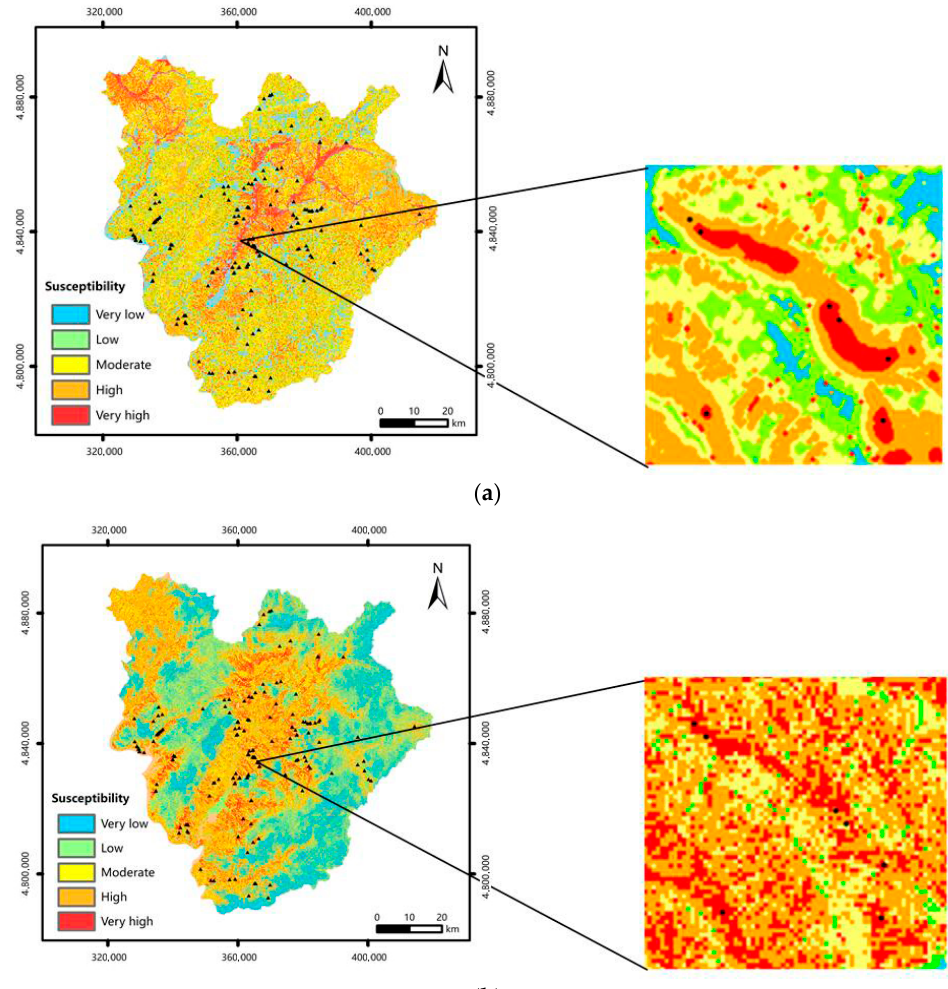
Figure 13. The maps of forecast results : ( a ) S-CN method and ( b ) T-CN method.